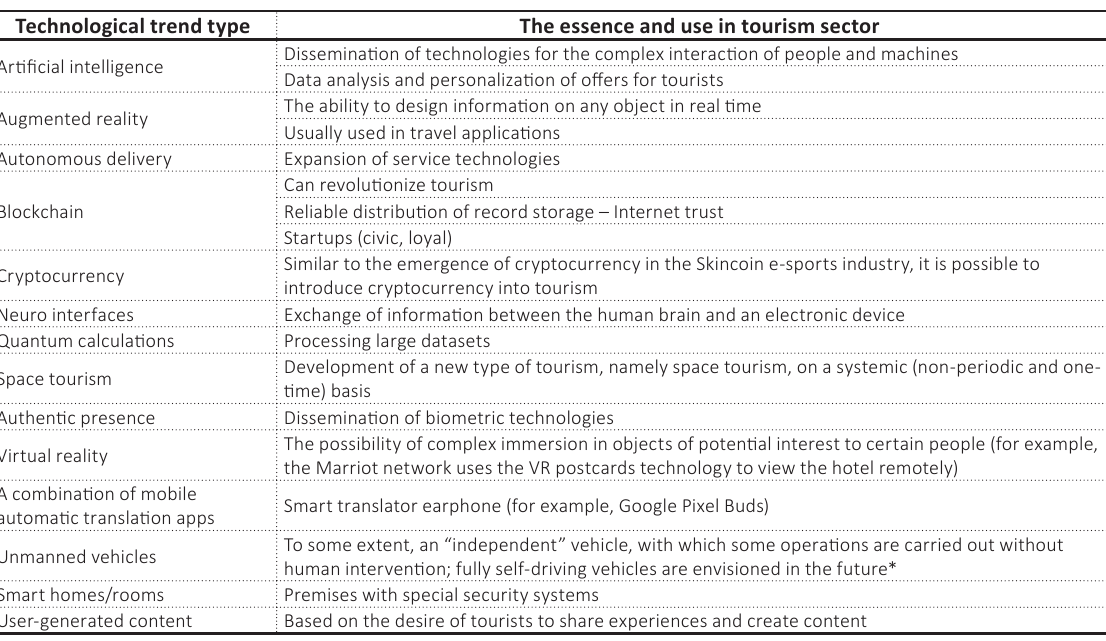
Table 5. Foresight studies of the impact of technological trends on tourism